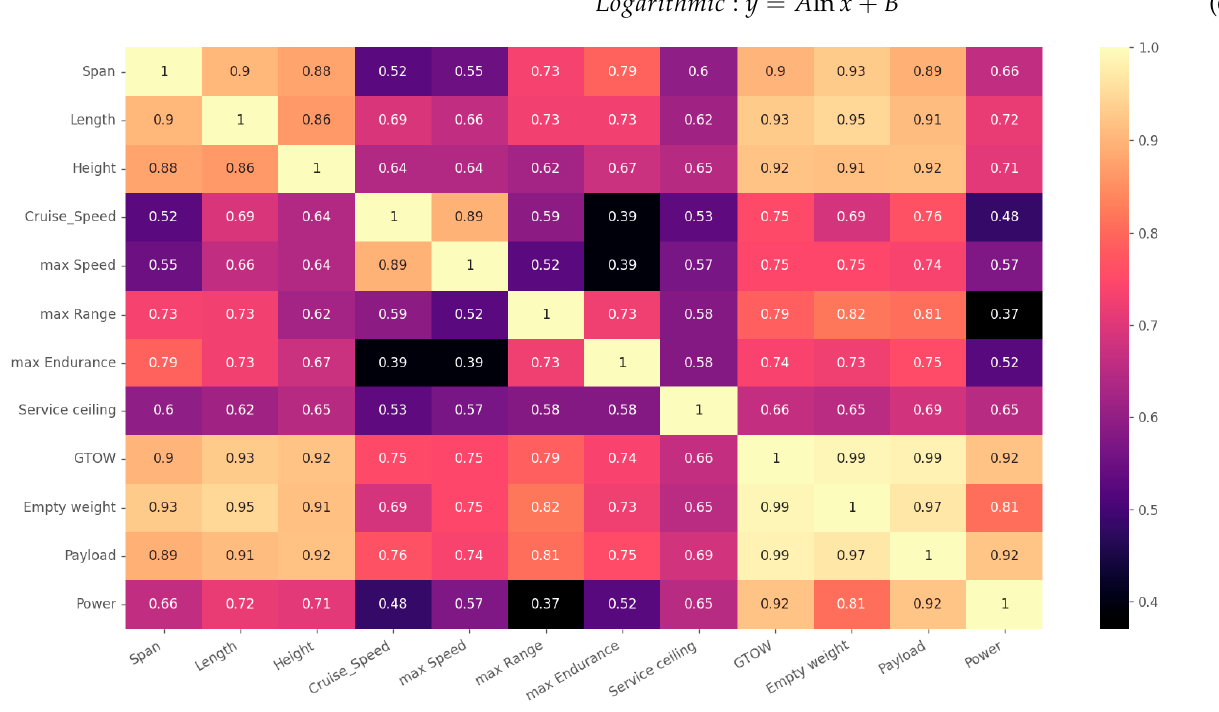
Figure 3. Parameters Spearman rank correlation coefficient heatmap, used to investigate potential correlations between the acquired data.